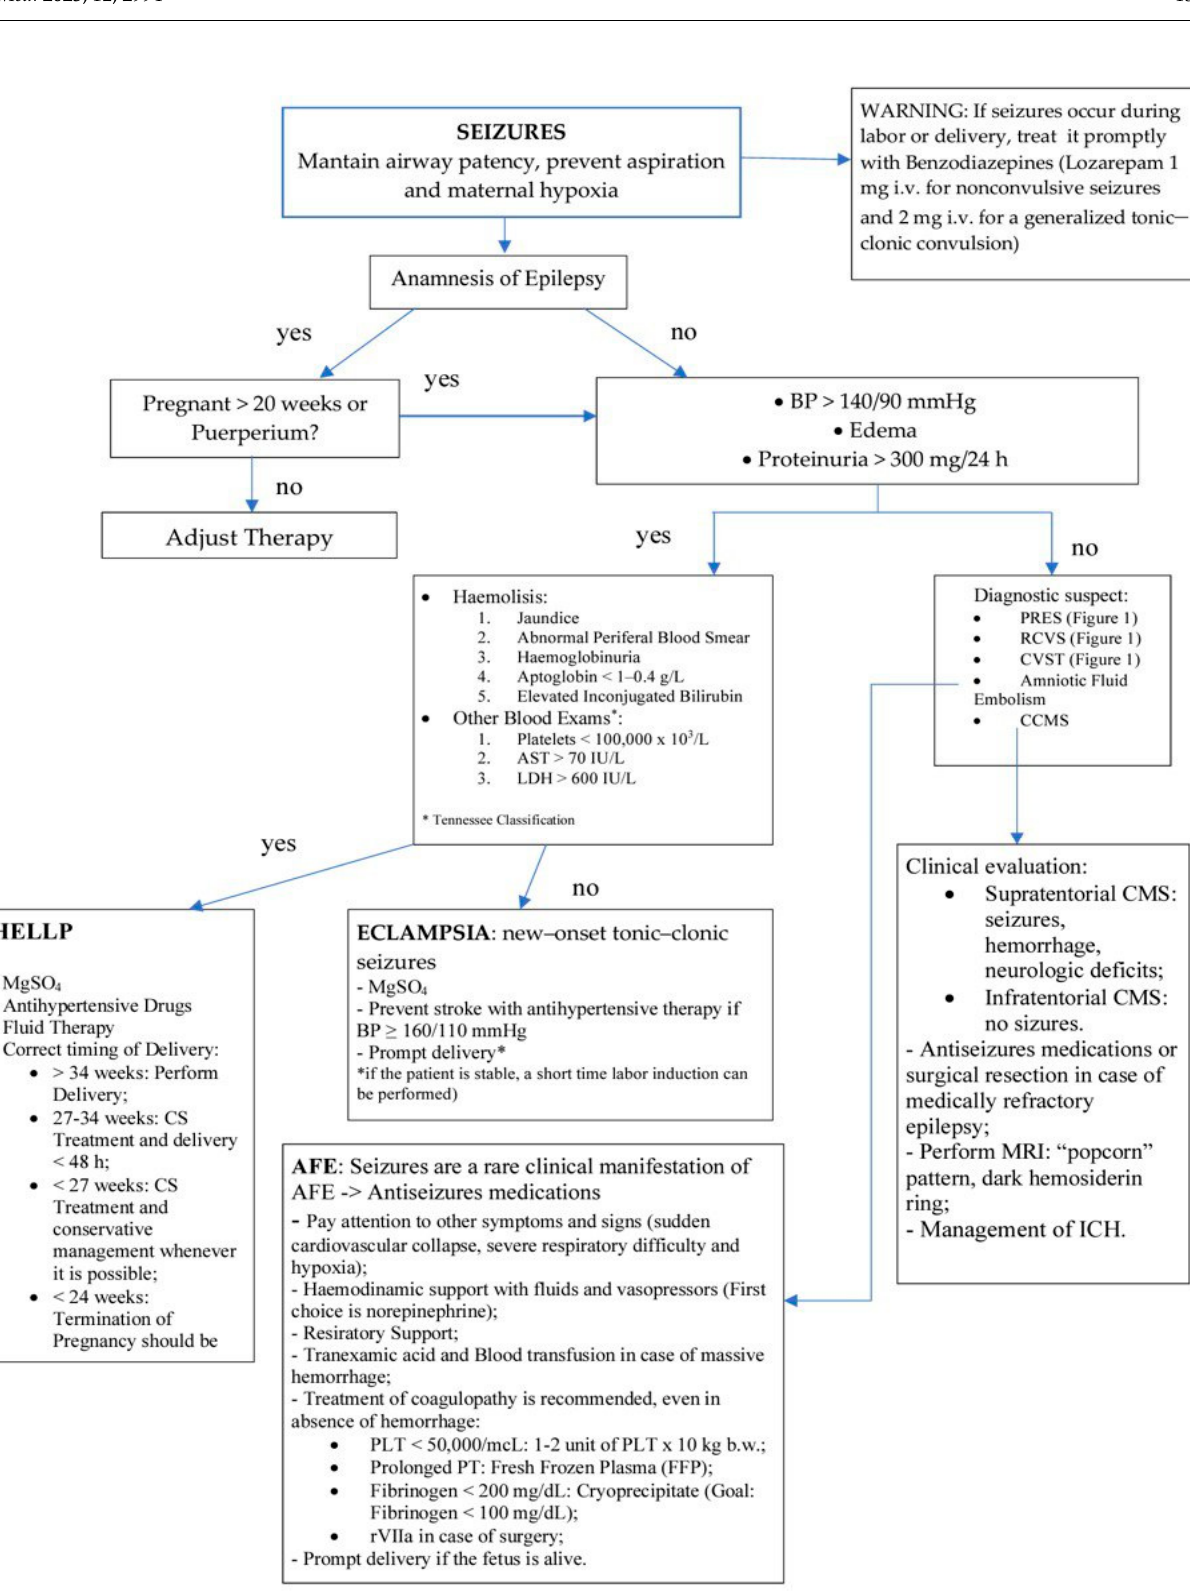
Figure 2. Algorithm for managing seizures in the clinical se tt ing.